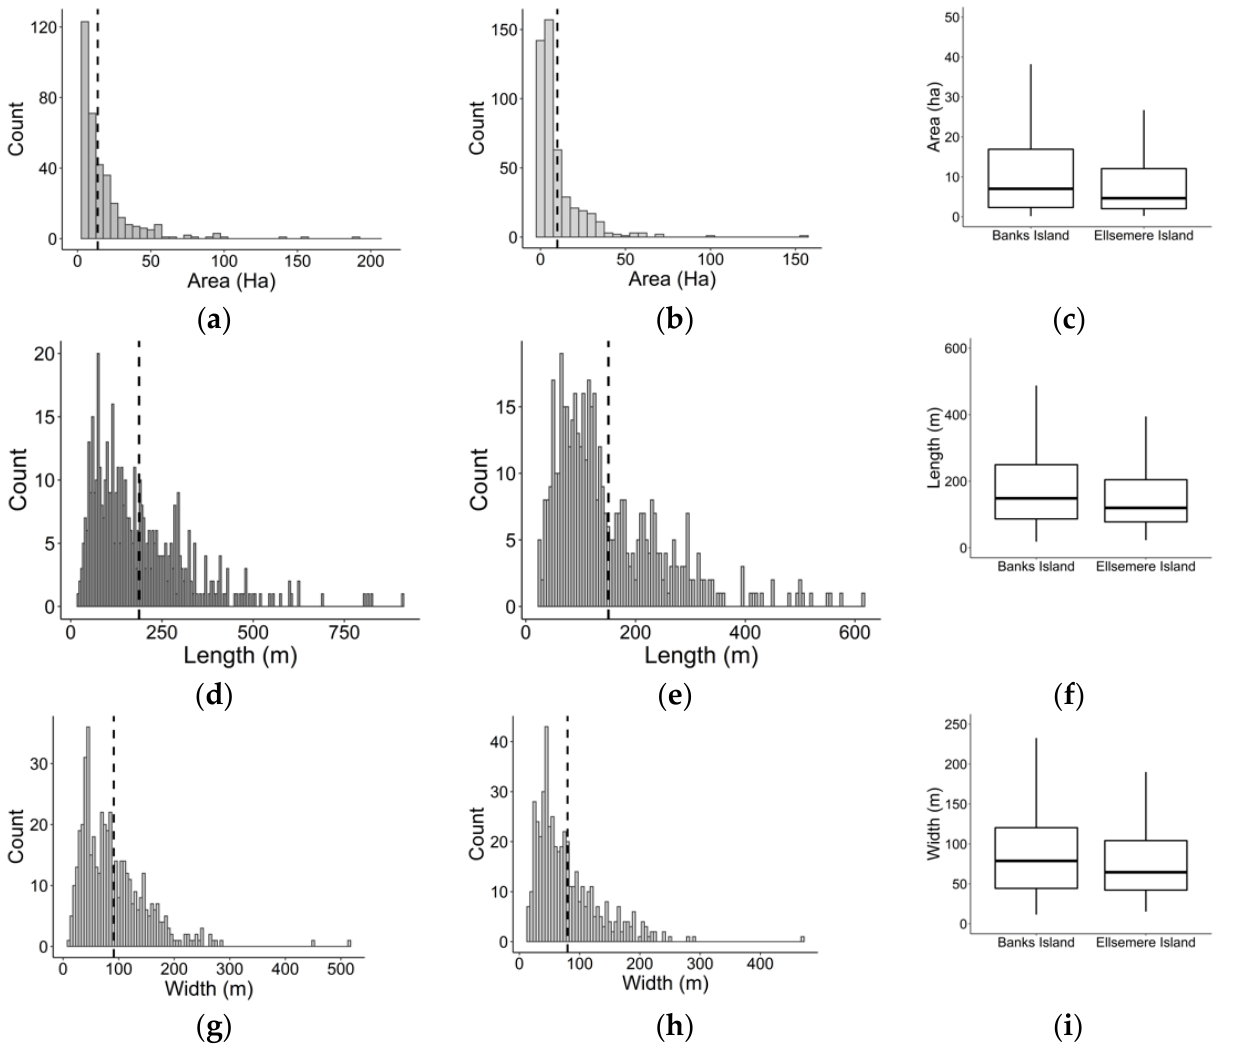
Figure 6. Distribution and comparison of area, width, and length parameters of the hand-annotated RTS samples from Banks Island and the Eureka Sound Lowlands. Histograms ( a , b ), ( d , e ), and ( g , h ) represent the RTS data distribution of area, length, and width, respectively, for two study sites. Boxplots ( c , f , l ) depict the area, length, and width of RTS samples from two study sites. ( a ) Histogram of RTS area based on hand-annotated samples from Banks Island. ( b ) Histogram of RTS area based on hand-annotated samples from the Eureka Sound Lowlands. ( c ) RTS area comparison of hand- annotated samples between the Eureka Sound Lowlands and Banks Island. ( d ) Histogram of RTS length (major axis) based on hand-annotated samples from Banks Island. ( e ) Histogram of RTS length (major axis) based on hand-annotated samples from the Eureka Sound Lowlands. ( f ) RTS length comparison of hand-annotated samples between the Eureka Sound Lowlands and Banks Island. ( g ) Histogram of RTS width (minor axis) based on hand-annotated samples from Banks Island. ( h ) Histogram of RTS width (minor axis) based on hand-annotated samples from the Eureka Sound Lowlands. ( i ) RTS width comparison of hand-annotated samples between the Eureka Sound Lowlands and Banks